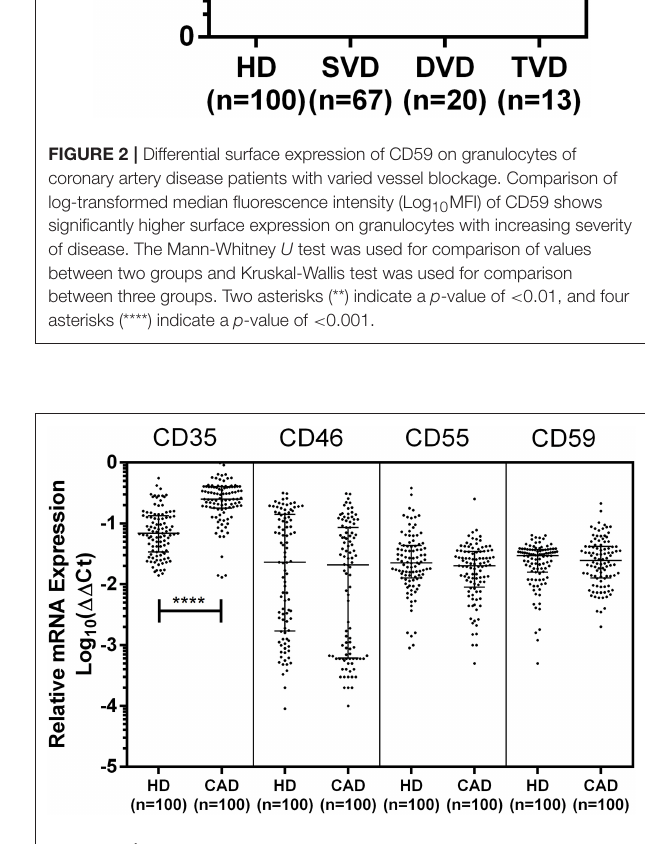
FIGURE 3 | Relative mRNA expression of complement regulatory proteins in coronary artery disease patients. Relative mRNA expression of CD35, CD46, CD55, and CD59 showed higher mRNA expression of CD35 in CAD patients. 11 Ct values were converted to logarithmic equivalents. Mann-Whitney U test was used for comparison of values between groups. Four asterisks (****) indicate a p -value of < 0.001. not significantly vary between the study groups. A significantly higher mRNA expression of CD35 was observed in the CAD patients than healthy donors ( p < 0.0001) ( Figure 3 ). The CD35 expression was comparable between CAD patients with different disease stages (data not